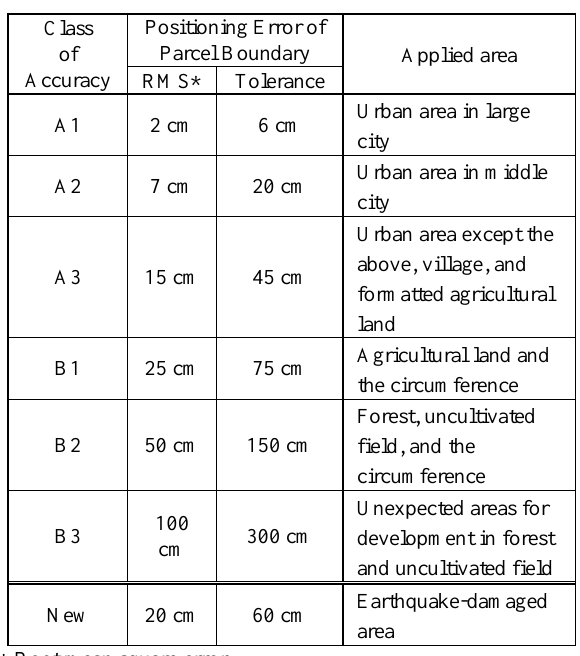
Table 1. National Land Survey Law with idea of